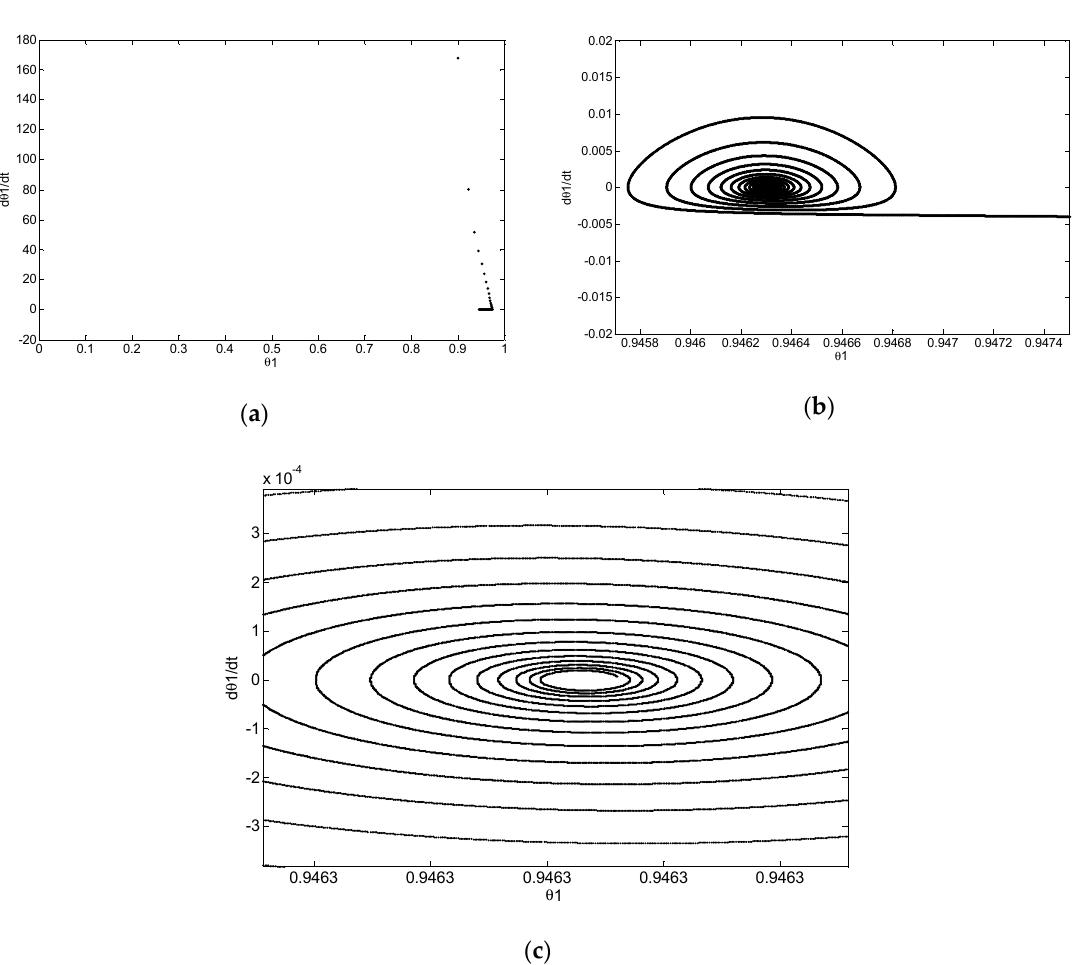
Figure 12. Superficial fractional coverage of carbon monoxide phase plane at 187.115 Pa and time step = 2 · 10 − 4 s. ( a ) without zoom, ( b ) zoom on the spiral and ( c ) more precise zoom on the spiral. The comments concerning the first zone are applicable to the third zone, Figure 13.